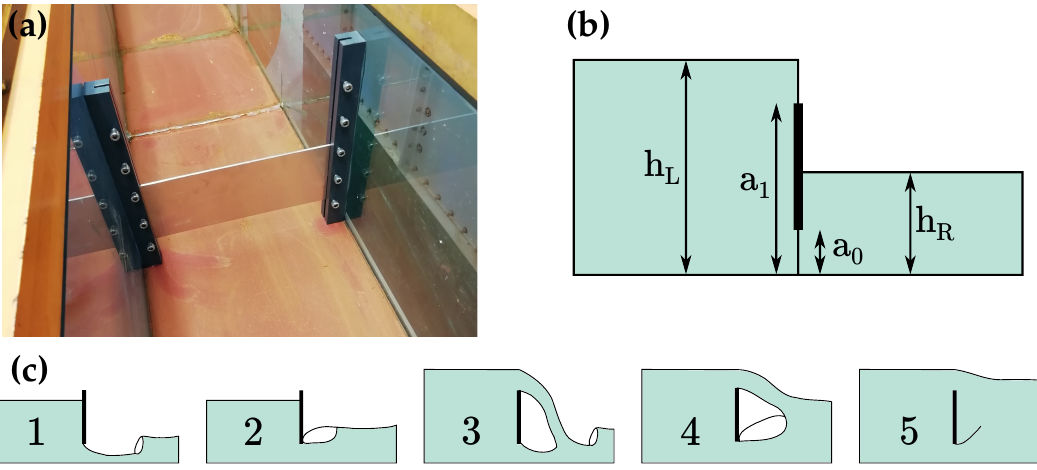
Figure 1. The leaky barrier model. ( a ) Physical model in the hydraulic flume. ( b ) Definition sketch for left-to-right flow. ( c ) Five operating stages, based partially on